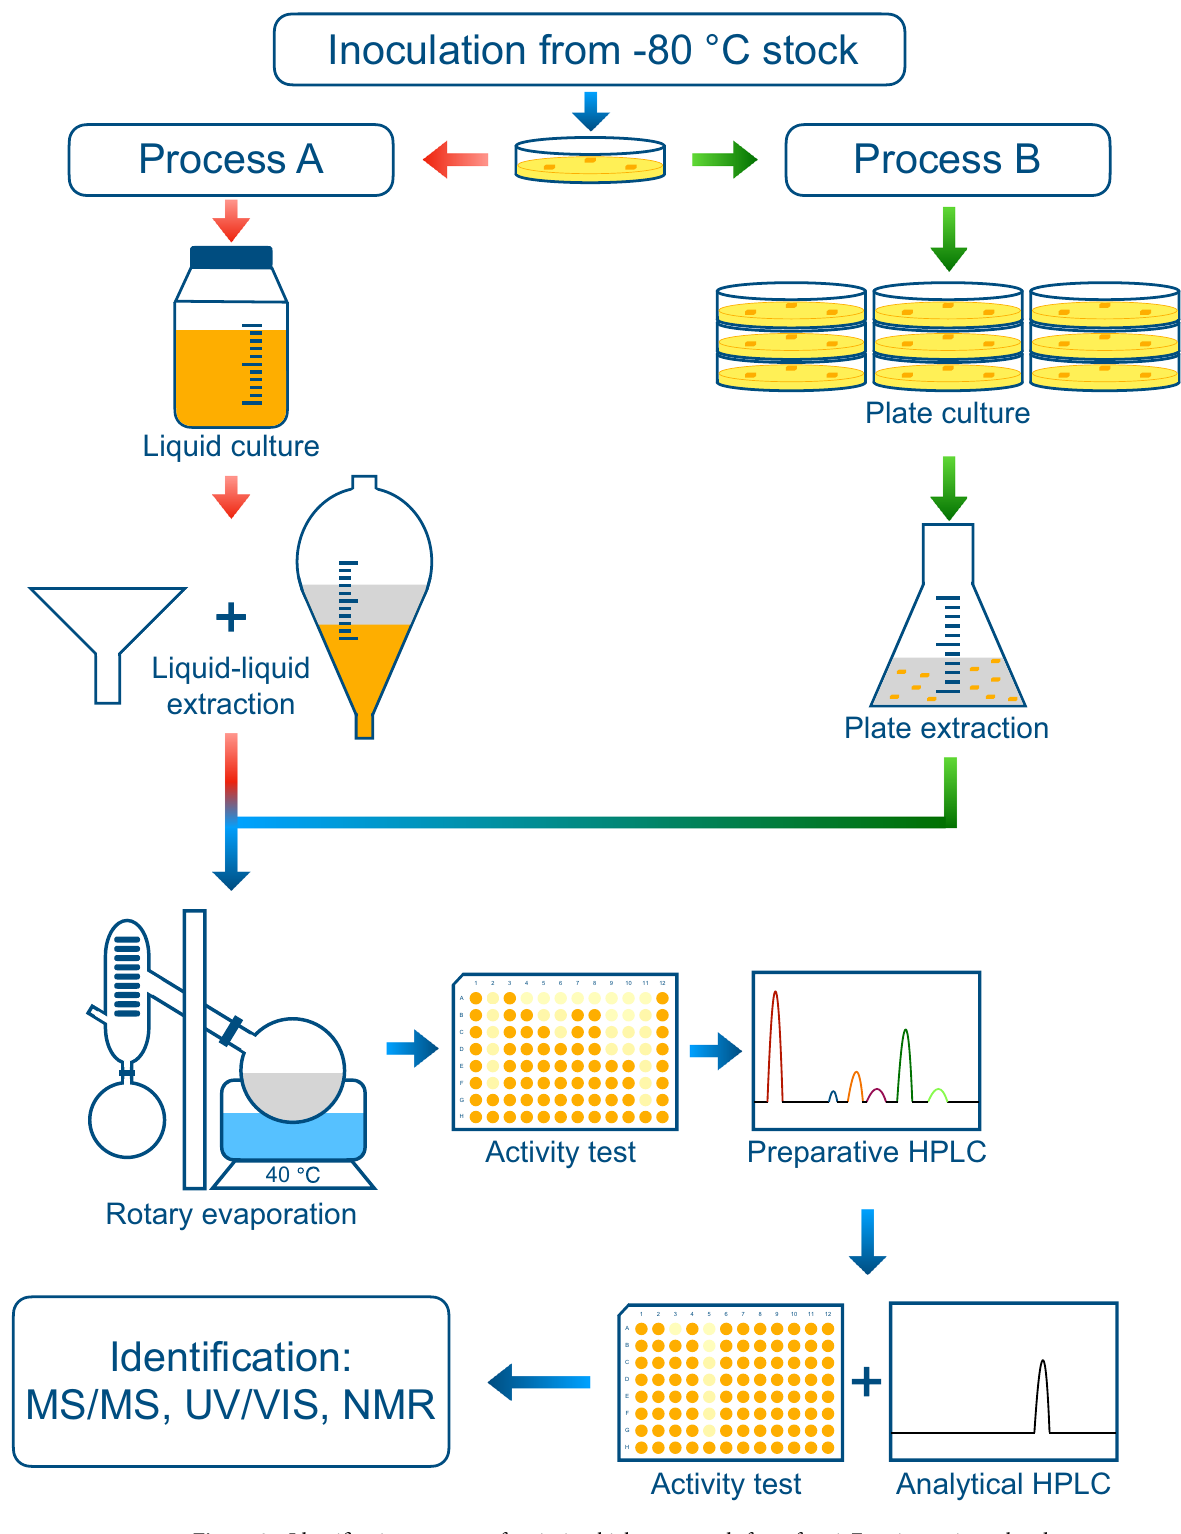
Figure 2. Identification strategy of antimicrobial compounds from fungi. Fungi were inoculated on agar plates and subsequently cultured in liquid media, filtrated by 0.22 µm filter, and extracted with ethyl acetate as shown in Process A (red arrows). Next, samples were concentrated using a rotary evaporator and tested for their antimicrobial activity in 96-well plates. Active samples were fractionated by preparative-HPLC, followed by activity (96-well plates) and purity (analytical HPLC) check. Pure active fractions were then identified by a combination of several chemical analyses. If the yield of active compounds was not sufficient by culturing in liquid medium, plate extraction (Process B, green arrows) was applied by culturing fungi on agar plates and extracting compounds with ethyl acetate directly from cultures on